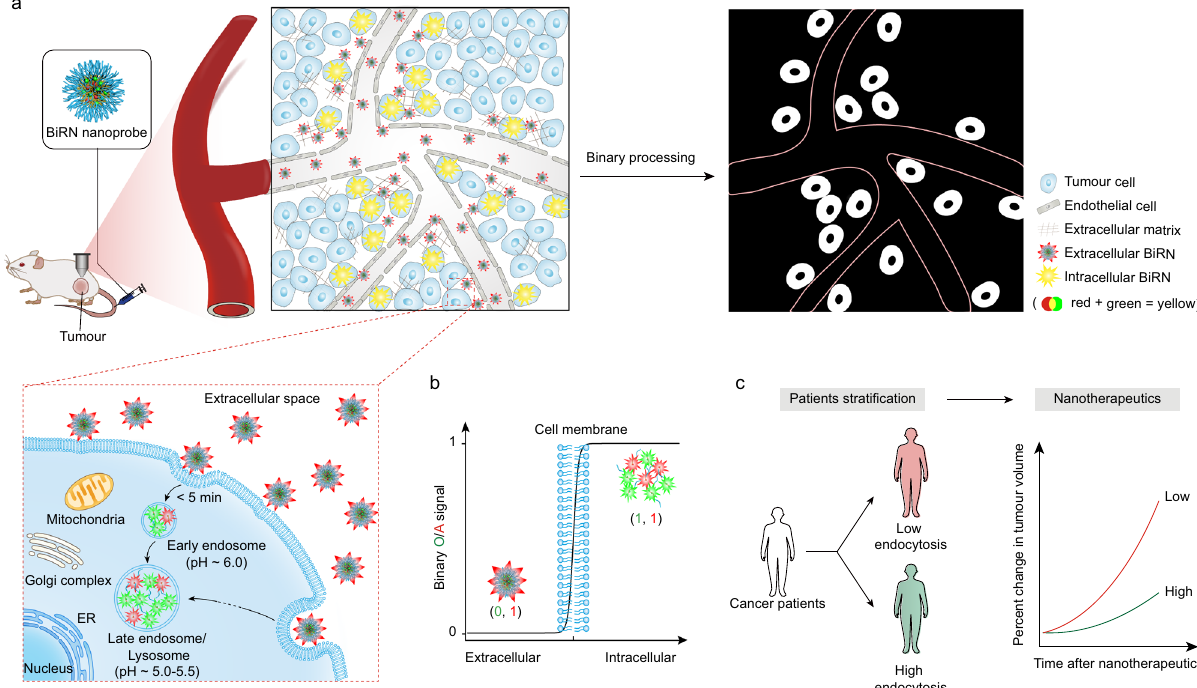
Fig. 1 Design and mechanism of BiRN for real-time quantitative imaging of cellular internalisation in vivo. a The schematic of internalisation and activation of BiRN nanoprobes in living mice. BiRN comprises ‘ OFF-ON ’ and ‘ always-ON ’ fl uorescence modules, serving as a binary pH threshold nanoreporter at pH 6.3. ‘ OFF-ON ’ module stays ‘ OFF ’ in tumour microcirculation and extracellular space (pH e = 6.6 – 6.9), and immediately turns ‘ ON ’ in early endosome (pH ~6.0) after endocytosis. ‘ Always-ON ’ module keeps constant fl uorescence intensity regardless of extra- and intracellular distribution. The ratiometric images ( F OFF-ON / F always-ON , O/A) remove all the extracellular signals and only internalised nanoprobes can be quanti fi ed (white punctate) after binary processing. b The ratiometric O/A signal of BiRN is a binary output (0 and 1) reporting the micro-distribution of nanoparticle in the extracellular (0) and intracellular (1) space. c Based on BiRN, we stratify cancer patients according to endocytosis amount and predict successfully the nanotherapeutic